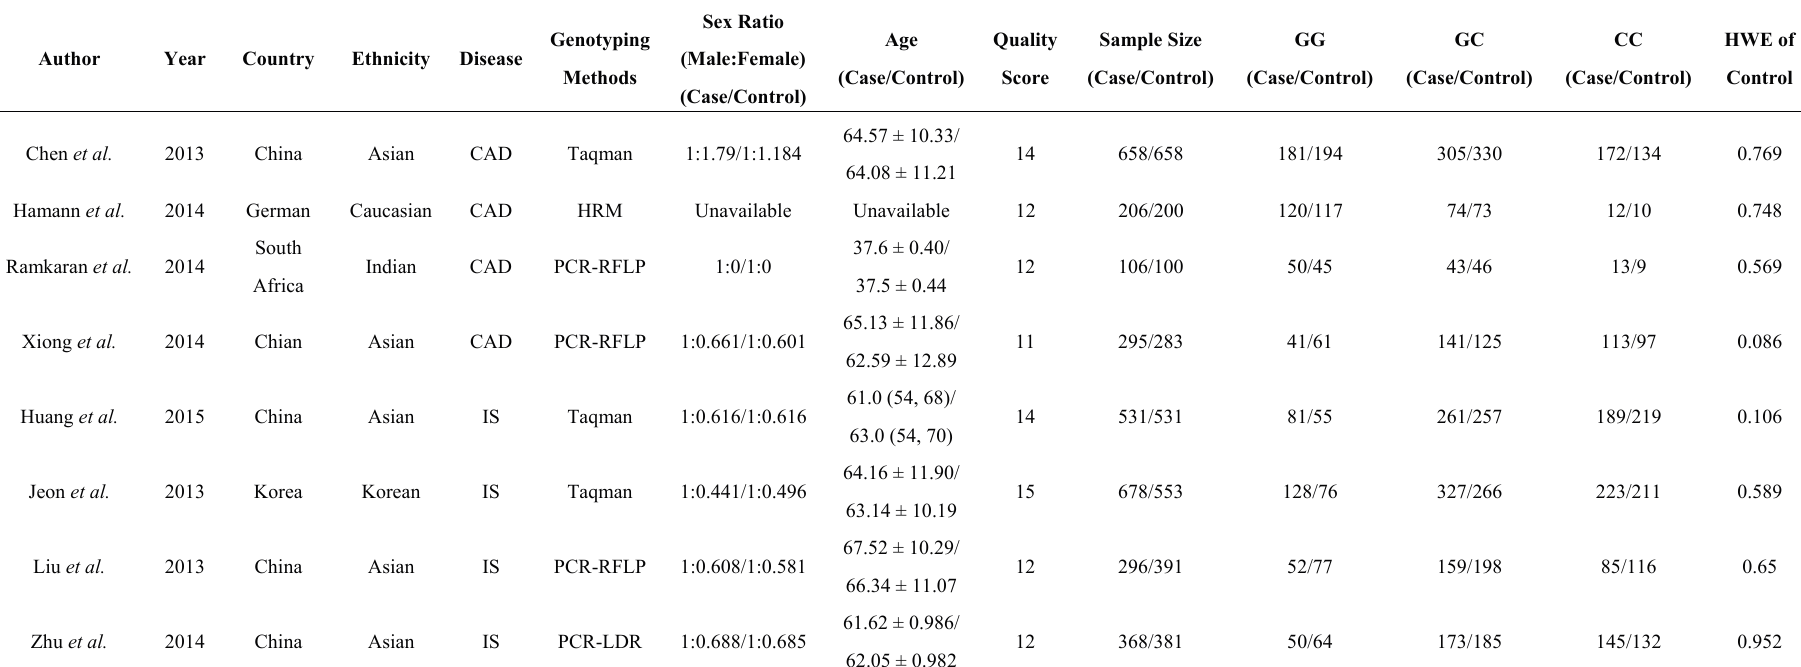
Table 1. Characteristics of eligible studies included in the